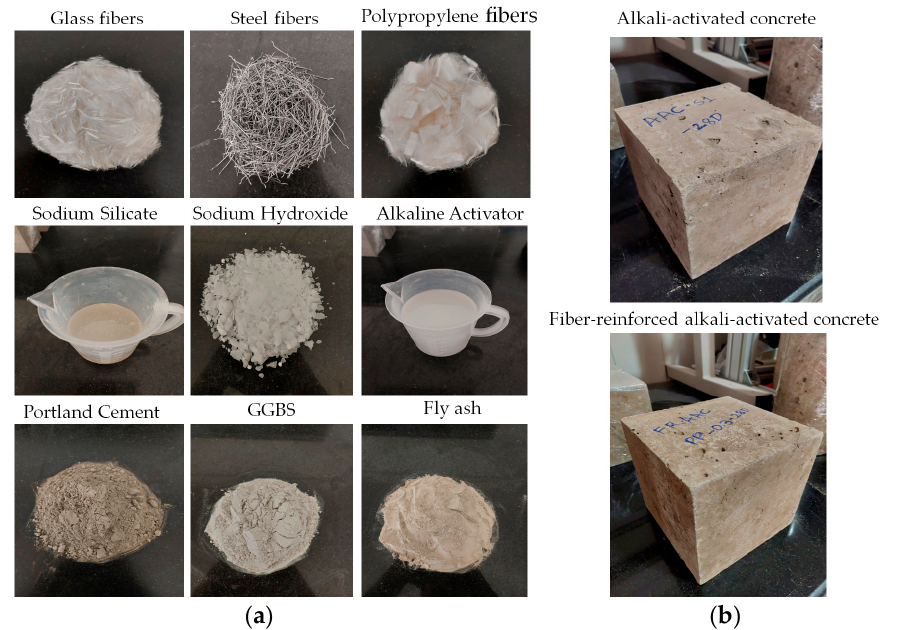
Figure 1. ( a ) Raw materials and ( b ) sample test specimens.